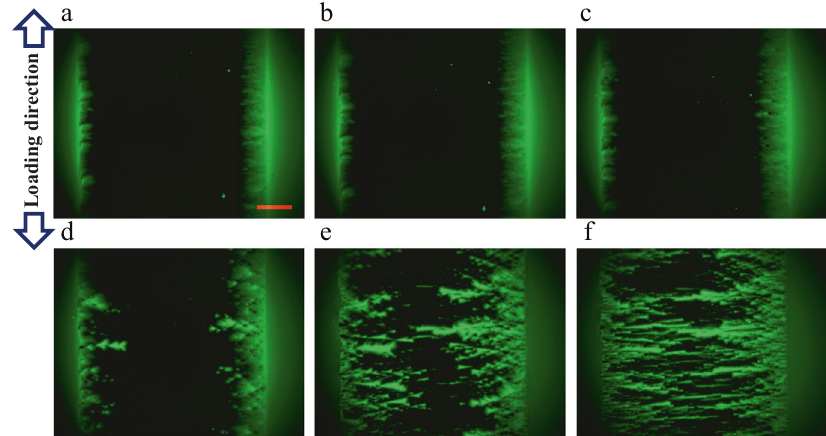
Fig. 2 Flux patterns measured at different tensile strains. The exerted strains under zero- fi eld-cooled conditions at 64 mT and 40 K from ( a ) to ( f ) are 0%, 0.40%, 0.72%, 0.75%, 0.78%, and 0.80%, respectively. Here, the scale bar represents 500 μ m.